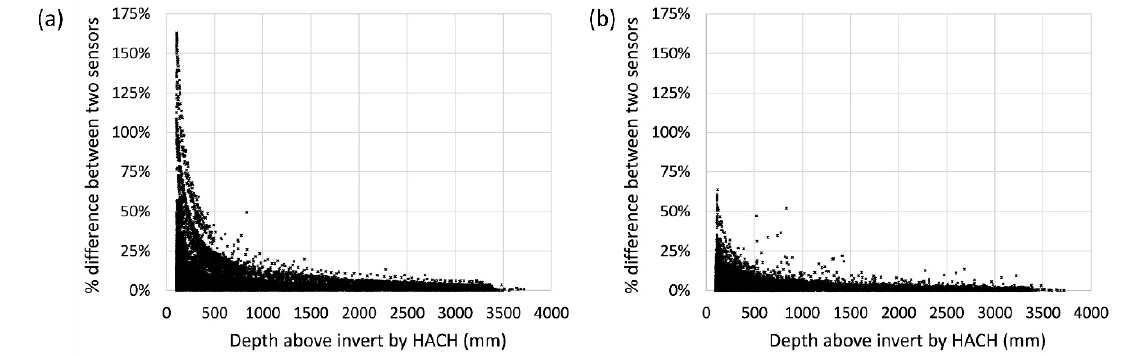
Figure 8. The percentage error between the low-cost and HACH sensors at different water levels: ( a ) low-cost sensor measurements with one offset calibration only; and ( b ) low-cost data with automated sensor re-calibration.